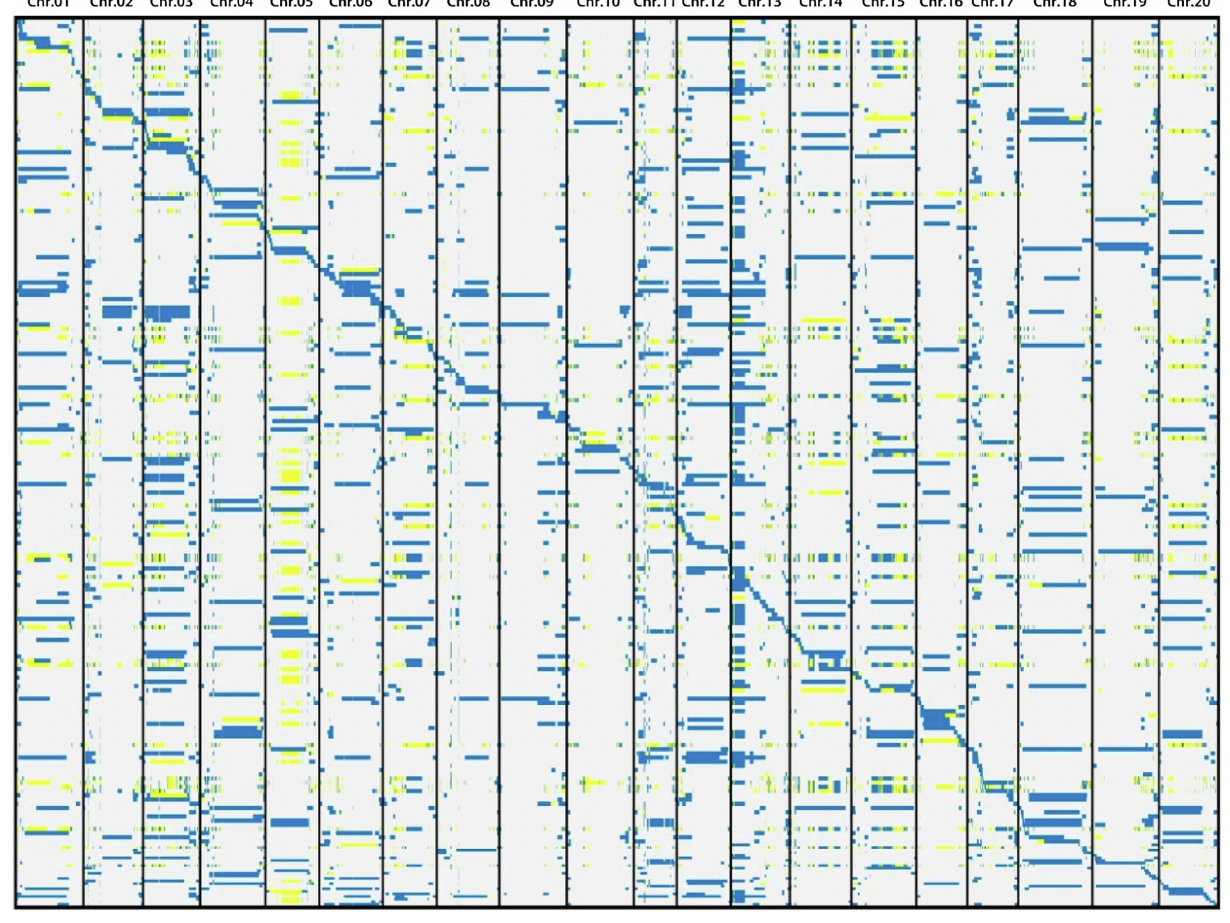
FIGURE 3 | Schematic diagram of introgressed fragments of 129 lines. Blue, white and yellow represent ZYD00006, suinong14 and heterozygote genotypes, respectively.